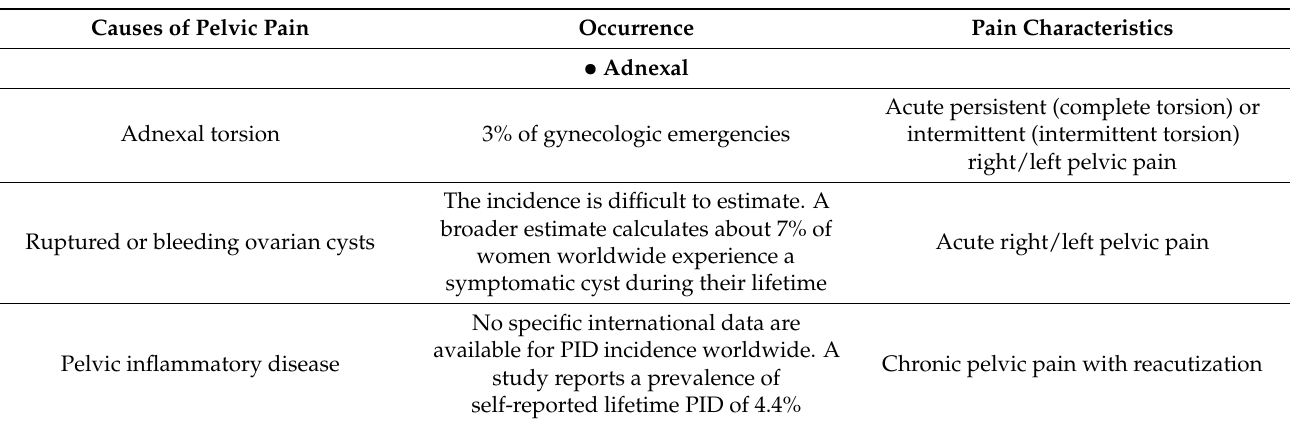
Table 2. Pelvic pain in reproductive age: causes, symptoms, and